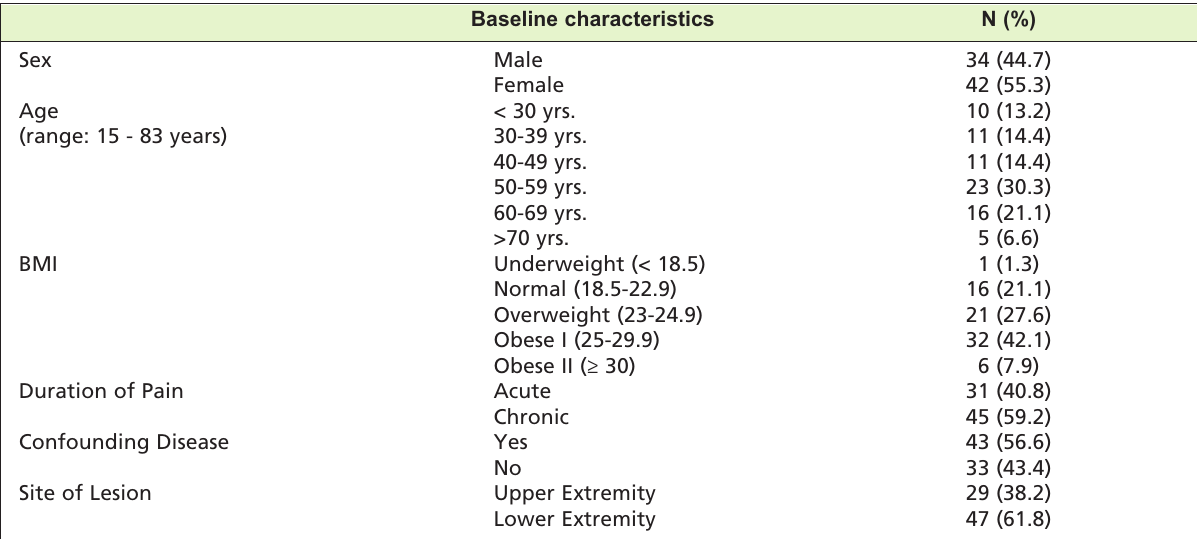
Subjects’ characteristics Table I: